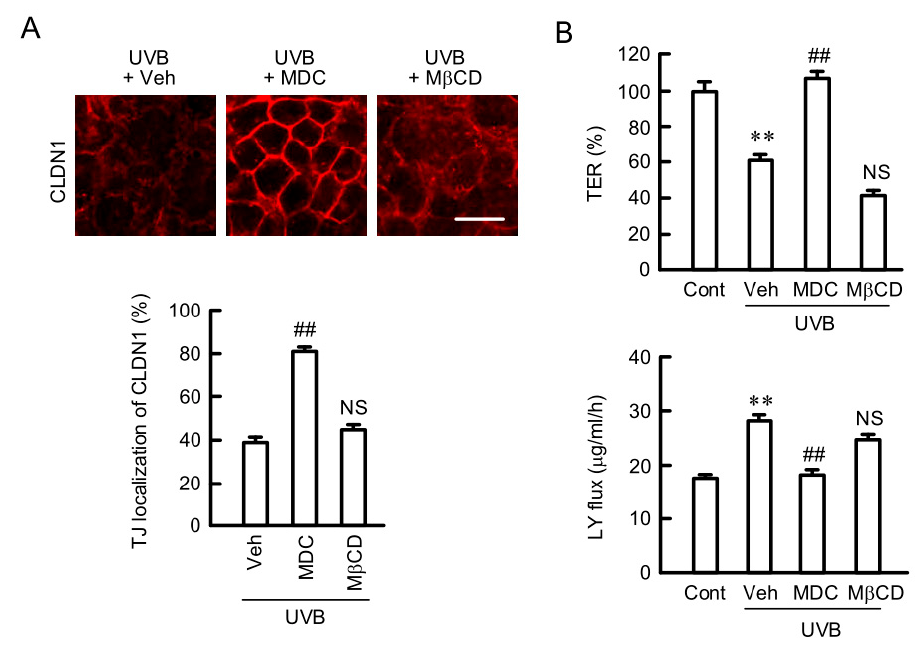
Figure 3. Effects of endocytosis inhibitors on the destruction of TJ barrier by weak UVB irradiation. After exposing to weak UVB, the cells were cultured for 6 h in the absence (Veh) and presence of 5 µ M monodansylcadaverine (MDC) or 10 µ M methyl- β -cyclodextrin (M β CD). Control cells (Cont) were cultured without exposure to UVB. ( A ) The cells were immunostained with anti-CLDN1 antibody. Scale bar indicates 10 µ m. The fluorescence values of CLDN1 at the TJ are shown as a percentage of the total fluorescence values. n = 4. ( B ) TER was measured using a volt-ohmmeter and represented as a percentage of the value of control. Paracellular LY flux was analyzed using a fluorescence spectrometry. n = 6. ** p < 0.01 vs. Cont. ## p < 0.01 and NS p > 0.05 vs. Veh.